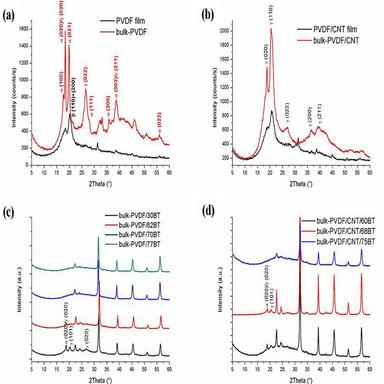
XRD patterns of film stacked bulk systems: (a) bulk-PVDF compared to the related solvent cast film; (b) bulk binary PVDF/xBT systems; (c) bulk ternary PVDF/CNT/xBT systems.